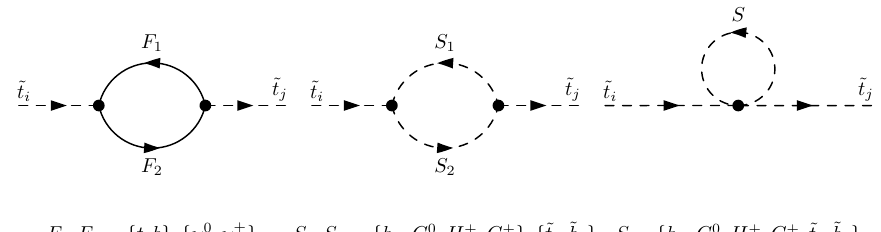
Figure 8 . Generic one-loop self-energies of the stops contributing at O ( (cid:11) t ) to the renormalization of the stop sector. A summation over all internal particles with indices a = 1 ; : : : ; 5, b = 1 ; 2 and c = 3 ; 4 ; 5 is